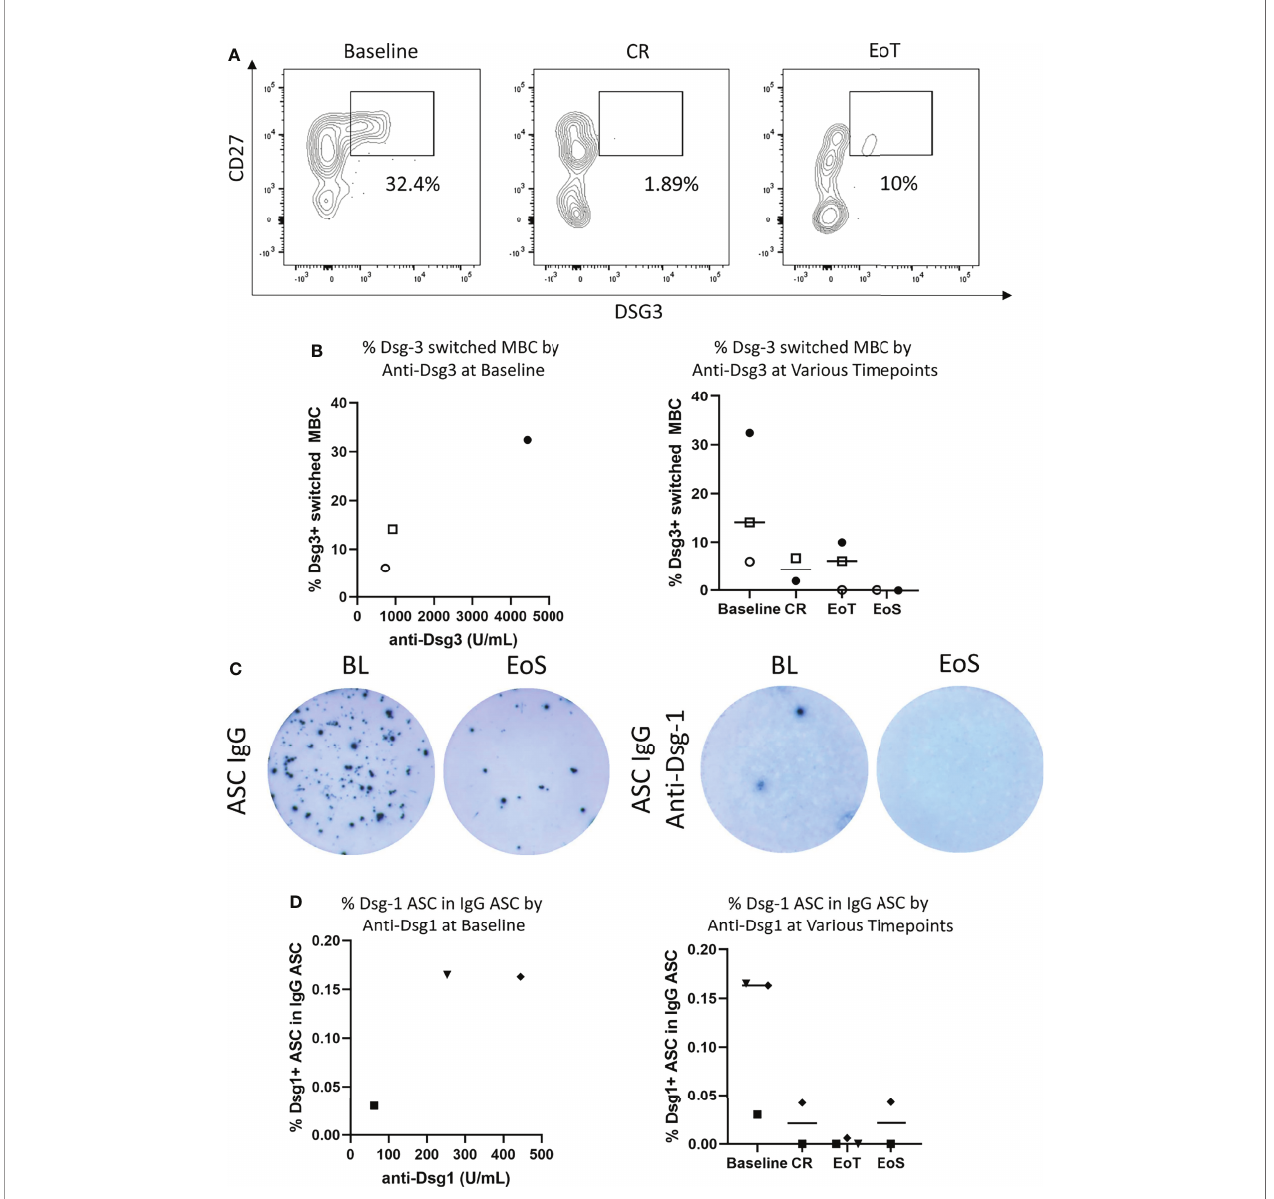
FIGURE 2 | Efgartigimod reduces antigen-speci fi c B cells in the blood. (A) Among the three PV participants with viable PBMC and sustained clinical response, representative fl ow cytometry plots depicting frequency of Dsg-3+ switched memory B cells (MBC) for one participant with PV at baseline, CR, and EoT were generated. (B) Frequency of circulating Dsg-3+ switched memory B cells in three participants with PV with sustained clinical response during the study in relation to Dsg-3 autoantibody serum titers at baseline and by time point. (C) Among the three PF participants with viable PBMCs, a representative ELISPOT of total IgG-ASCs with 2.5 × 10 3 to 1 × 10 4 PBMCs plated per well (left) and Dsg-1 IgG ASCs with 1 × 10 5 to 4 × 10 5 PBMCs plated per well (right) detected in PBMCs of a participant with PF. (D) Frequency of peripheral blood Dsg-1-speci fi c ASCs evaluated by ELISPOT assay in 3 participants with PF during study both in relation to Dsg-1 autoantibody serum titers at baseline and by time point. Frequencies are reported as a percentage of total IgG ASC. ASCs, antibody- secreting cells; BL, baseline; CR, complete clinical remission; EoT, end of treatment; EoS, end of